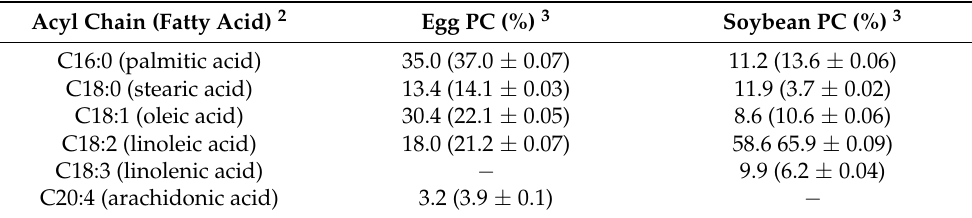
Table 2. Some of the results obtained from the determination of the acyl chain composition in egg PC and soybean PC 1 .